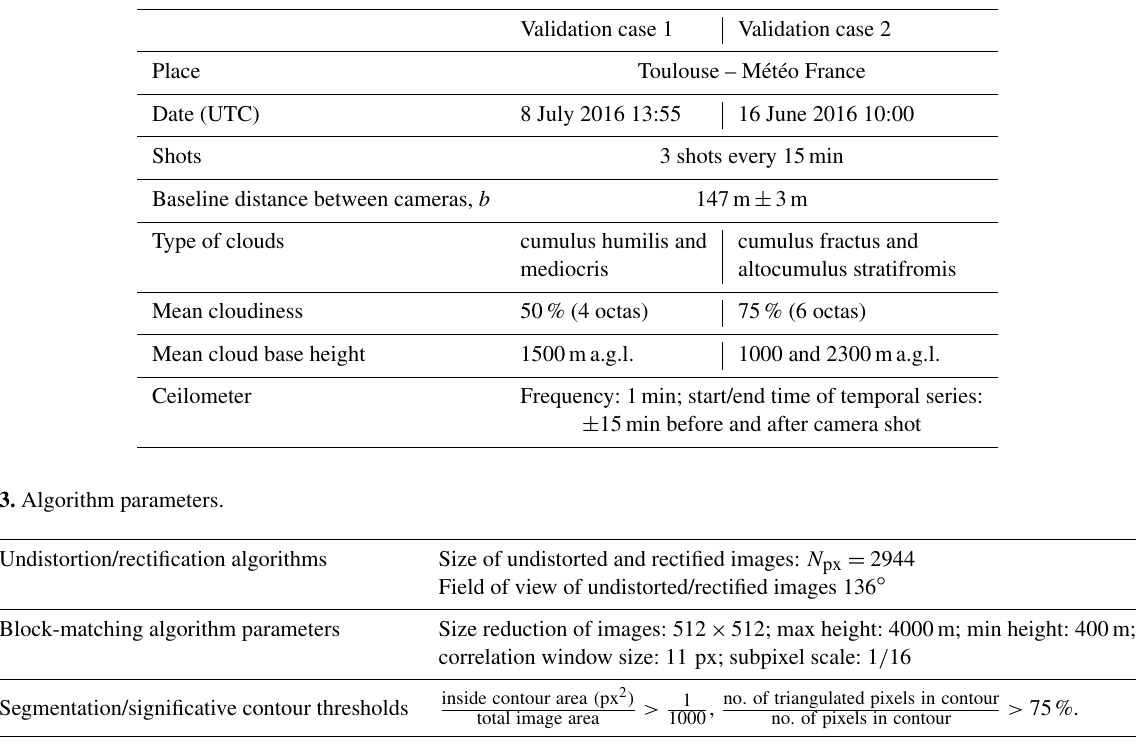
Table 2. Description of validation cases.